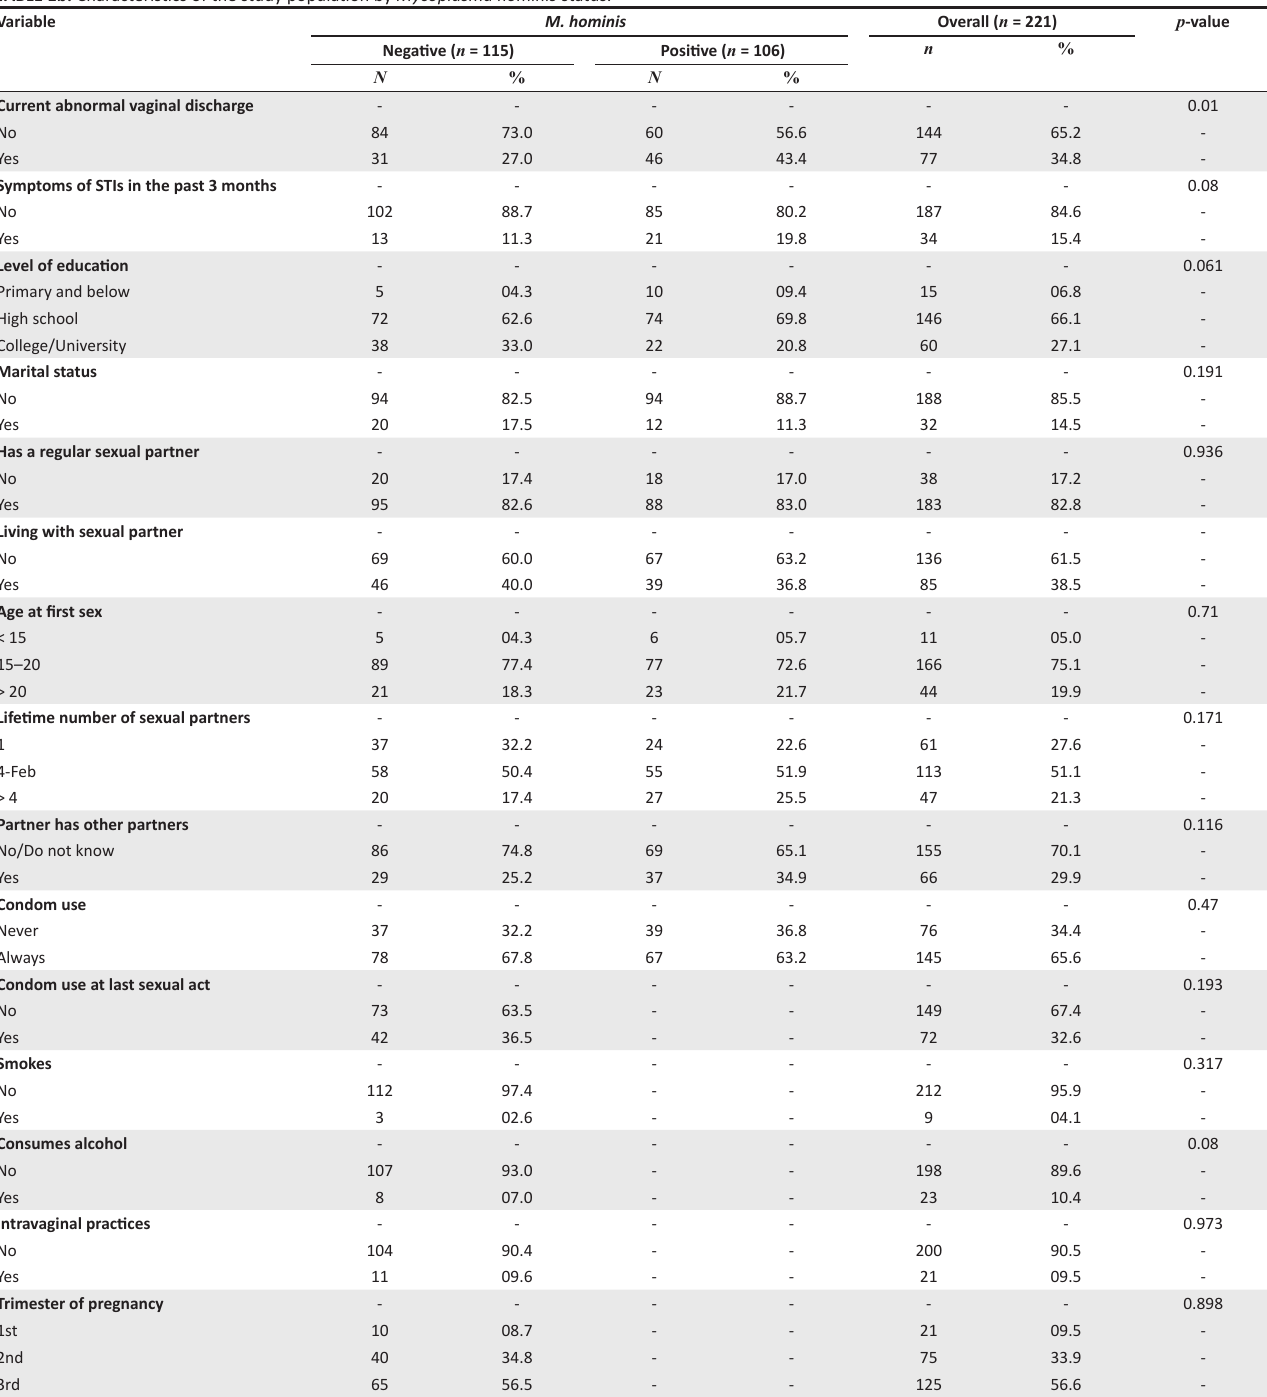
TABLE 1b: Characteristics of the study population by Mycoplasma hominis status. Variable